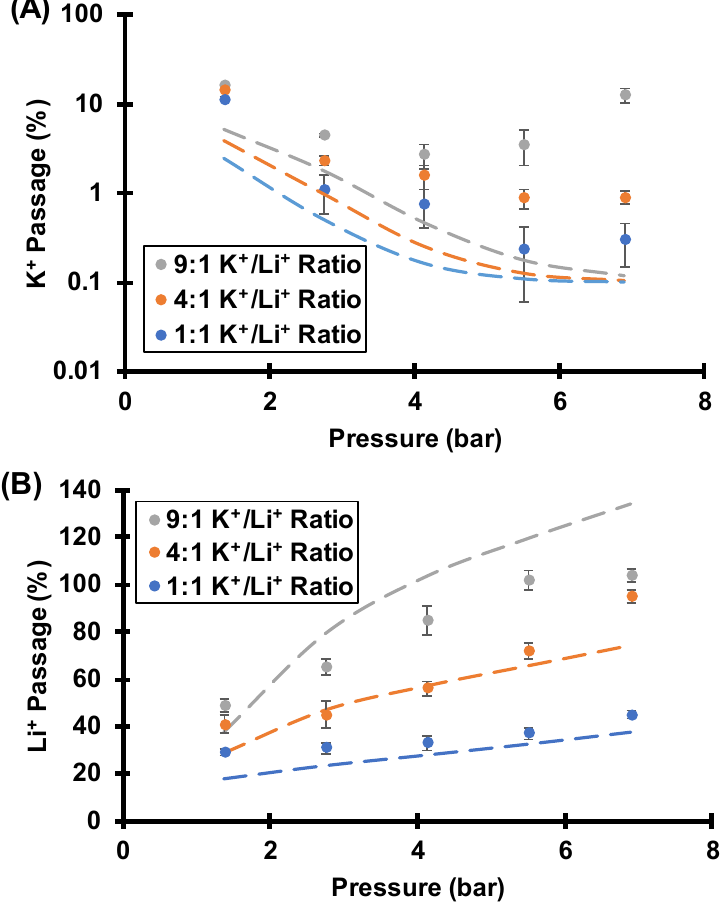
Figure 12. K + ( A ) and Li + ( B ) passages during flow of various 0.1 mM ionic strength KCl and LiCl mixtures through track-etched membranes (30 nm pores) using various transmembrane pressures and a 1000 rpm rotation rate. Dashed lines are simulated passages assuming a surface charge density of − 2.2 mC/m 2 , a pore diameter of 30 nm, and a boundary layer thickness of 19.4 µ m. The simulation also incorporates a 0.1% membrane defect area. Table S4 in the supplementary materials gives the experimental data and selectivities.